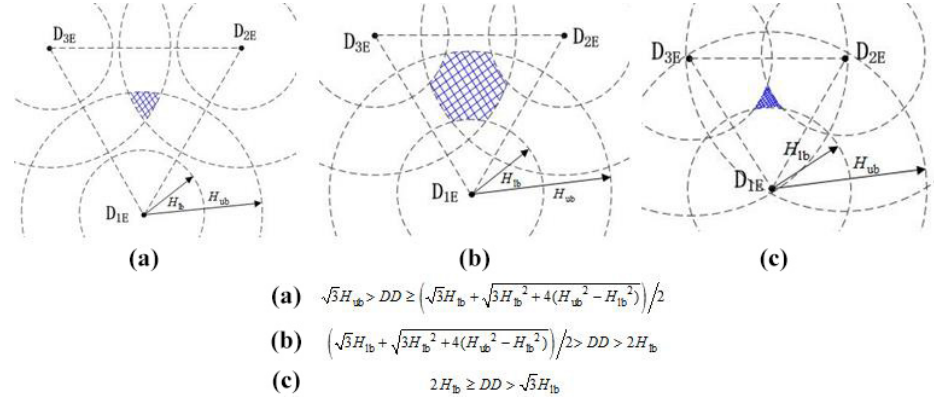
Figure 7. Three categories of type I work space.